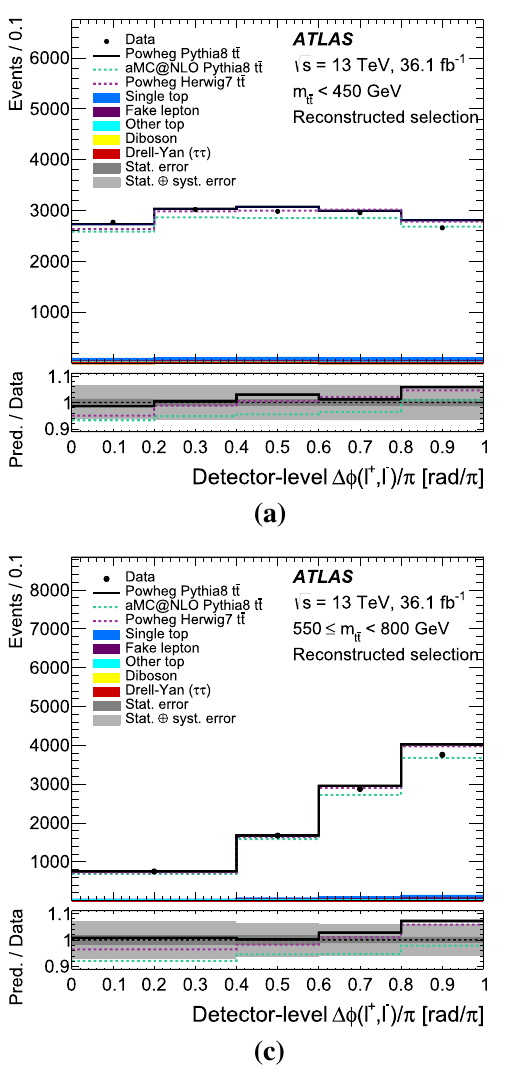
Fig. 4 Kinematic distributions after the requirement of at least two b -tagged jets and Neutrino Weighting (reconstructed selection). The plots display (cid:3)φ/π in individual mass ranges: a m t ¯ t < 450 GeV, b 450 ≤ m t ¯ t < 550GeV, c 550 ≤ m t ¯ t < 800GeV,and d m t ¯ t ≥ 800GeV. The dark uncertainty bands in the ratio plots represent the statistical uncertainties while the light uncertainty bands represent the statisti- cal and systematic uncertainties added in quadrature. The systematic